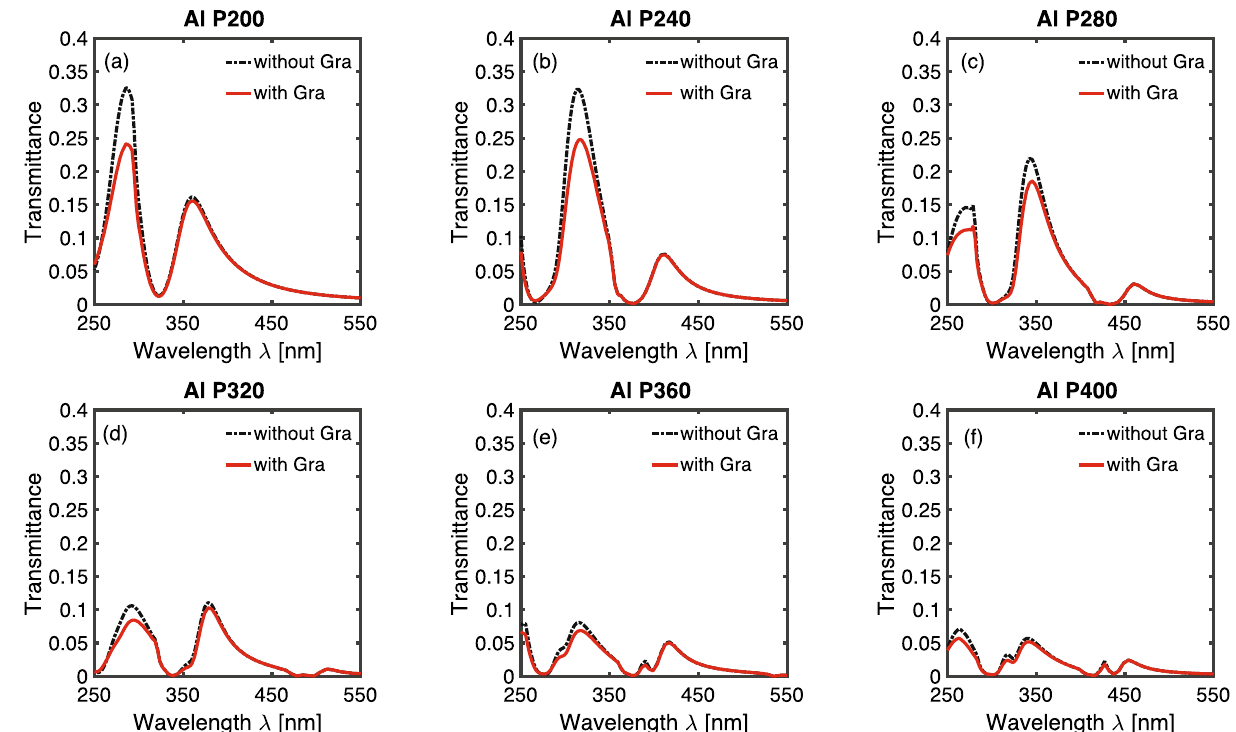
Figure 2. Transmission spectrum of an aluminum hole-array with and without graphene. The periodicities of the aluminum hole-arrays are ( a ) 200 nm ( b ) 240 nm ( c ) 280 nm ( d ) 320 nm ( e ) 360 nm ( f ) 400 nm. The dashed black curve represents the spectrum for an aluminum hole-array without graphene layer; the solid red line corresponds to the spectrum for an aluminum hole-array with an intrinsic graphene